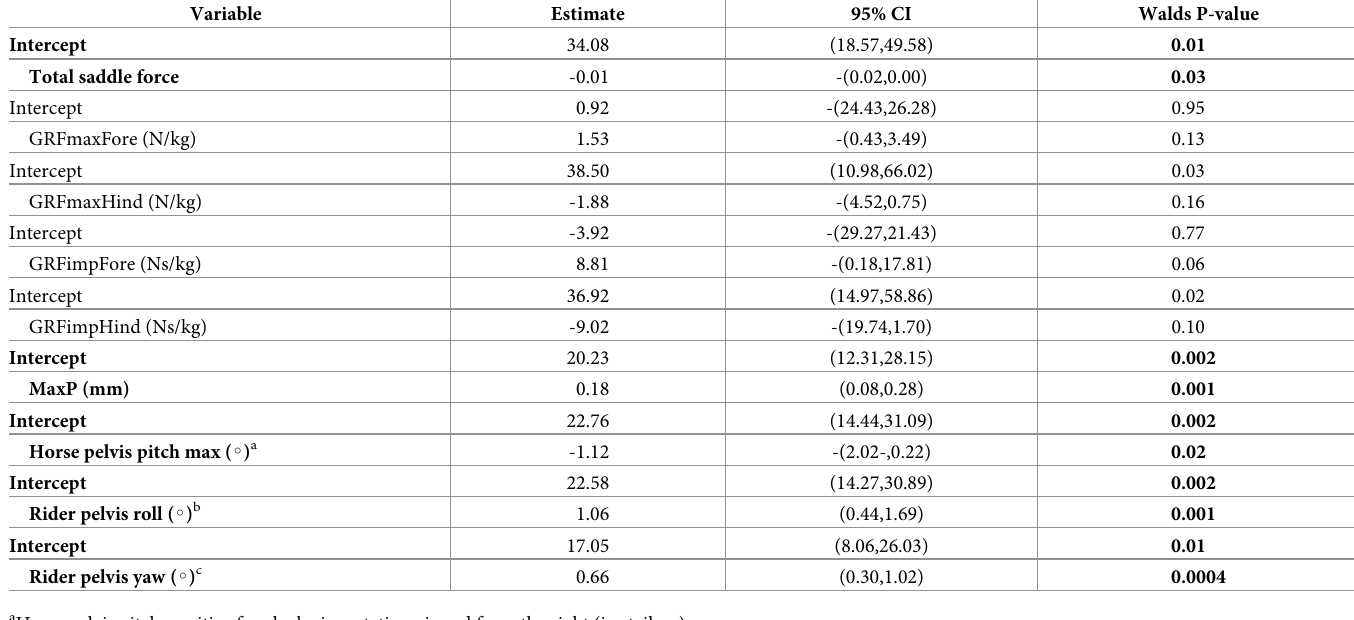
a Horse pelvis pitch; positive for clockwise rotation viewed from the right (i.e. tail up) b Rider pelvis roll; positive for rotation away from the supporting hindlimb side c Rider pelvis yaw; positive for rotation away from the supporting hindlimb